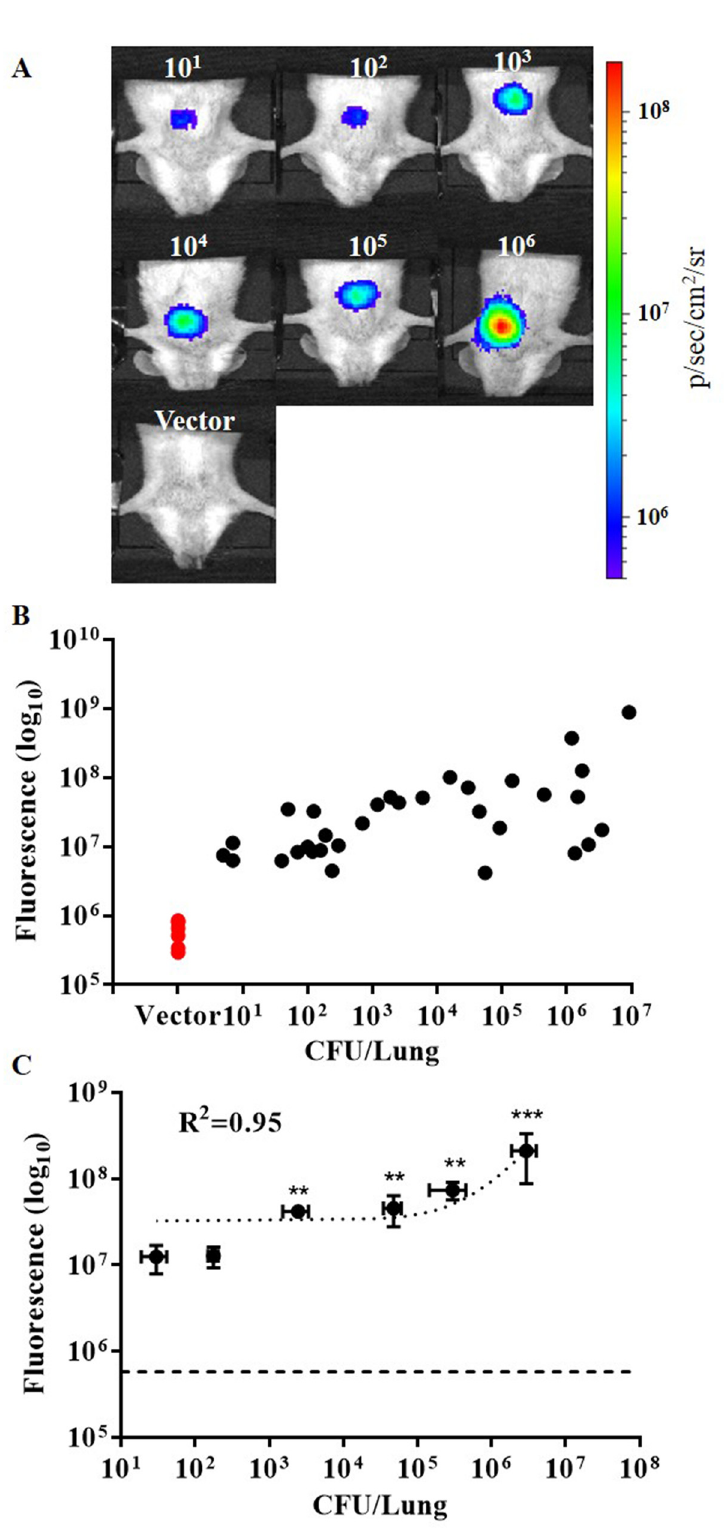
Fig 4. Intravital fluorescence excitation of tdTomato expressing BCG after intratracheal pulmonary infection of mice. (A) Representative whole-body images acquired using integrated microendoscope (intravital fiber excitation) at 24 hr post-infection with 10 1 − 10 6 colony forming units (CFU) BCG17 (tdTomato